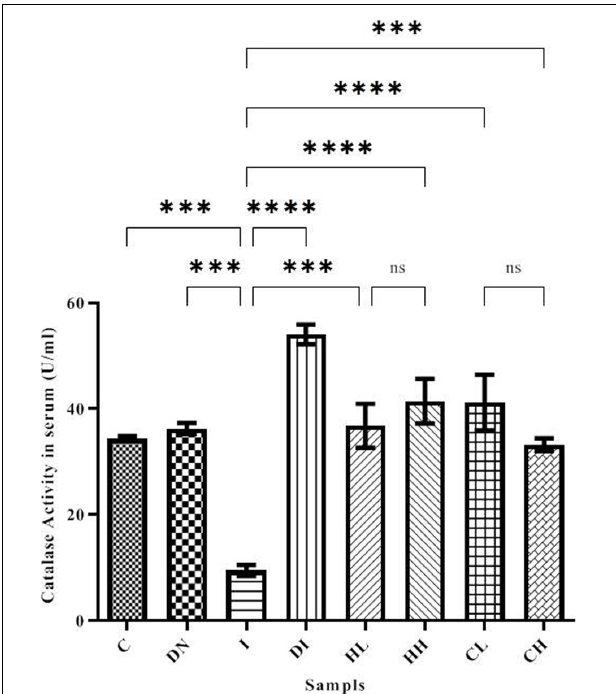
FIGURE 5 | CAT activity in the serum of the treated mice, Group C, control group: Normal saline-receiving group; Group DN, normal saline and deferoxamine-receiving group; Group I, iron dextran and normal saline-receiving group; Group DI, iron dextran and deferoxamine-receiving group; Group HL, low dose hesperidin-receiving group; Group HH, high dose hesperidin-receiving group; Group CL, low dose coumarin-receiving group; and Group CH, high dose coumarin-receiving group (Mean ± SD; ∗∗∗ p ≤ 0.001, ∗∗∗∗ p ≤ 0.0001, ns: non-significant).